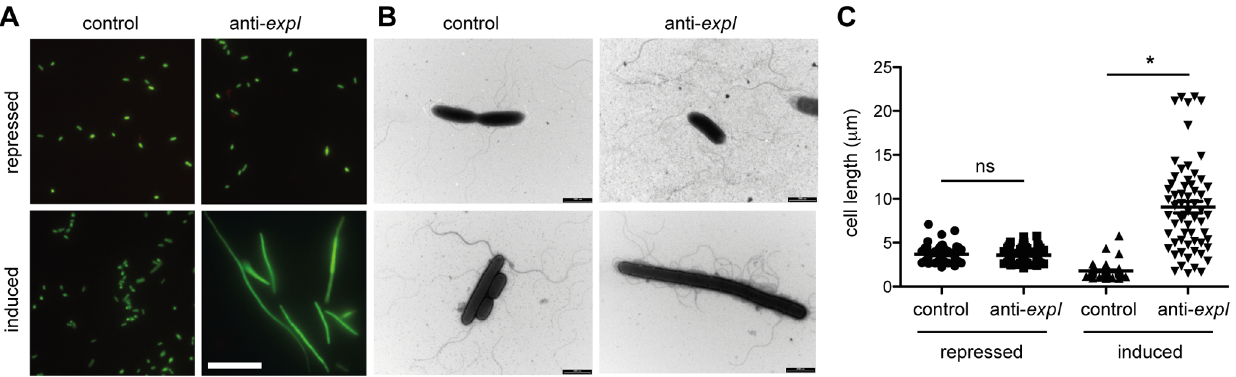
Figure 3. Chromosomal targeting results in cell elongation indicative of DNA damage. Plasmids containing no spacers (control; pC1-16) or one spacer targeting expI (anti- expI ; pE1-16) were repressed or induced in the WT and then visualised by (A) LIVE/DEAD staining and fluorescence microscopy (white scale bar; 20 m m; all images to scale) or (B) transmission electron microscopy (TEM) (black scale bars; 2 m m) (C) Quantification of cell lengths of 60 cells from each treatment as assessed by TEM. ns, not significant; *, p-value of , 0.0001 when assessed by unpaired two-tailed t-test (PRISM).